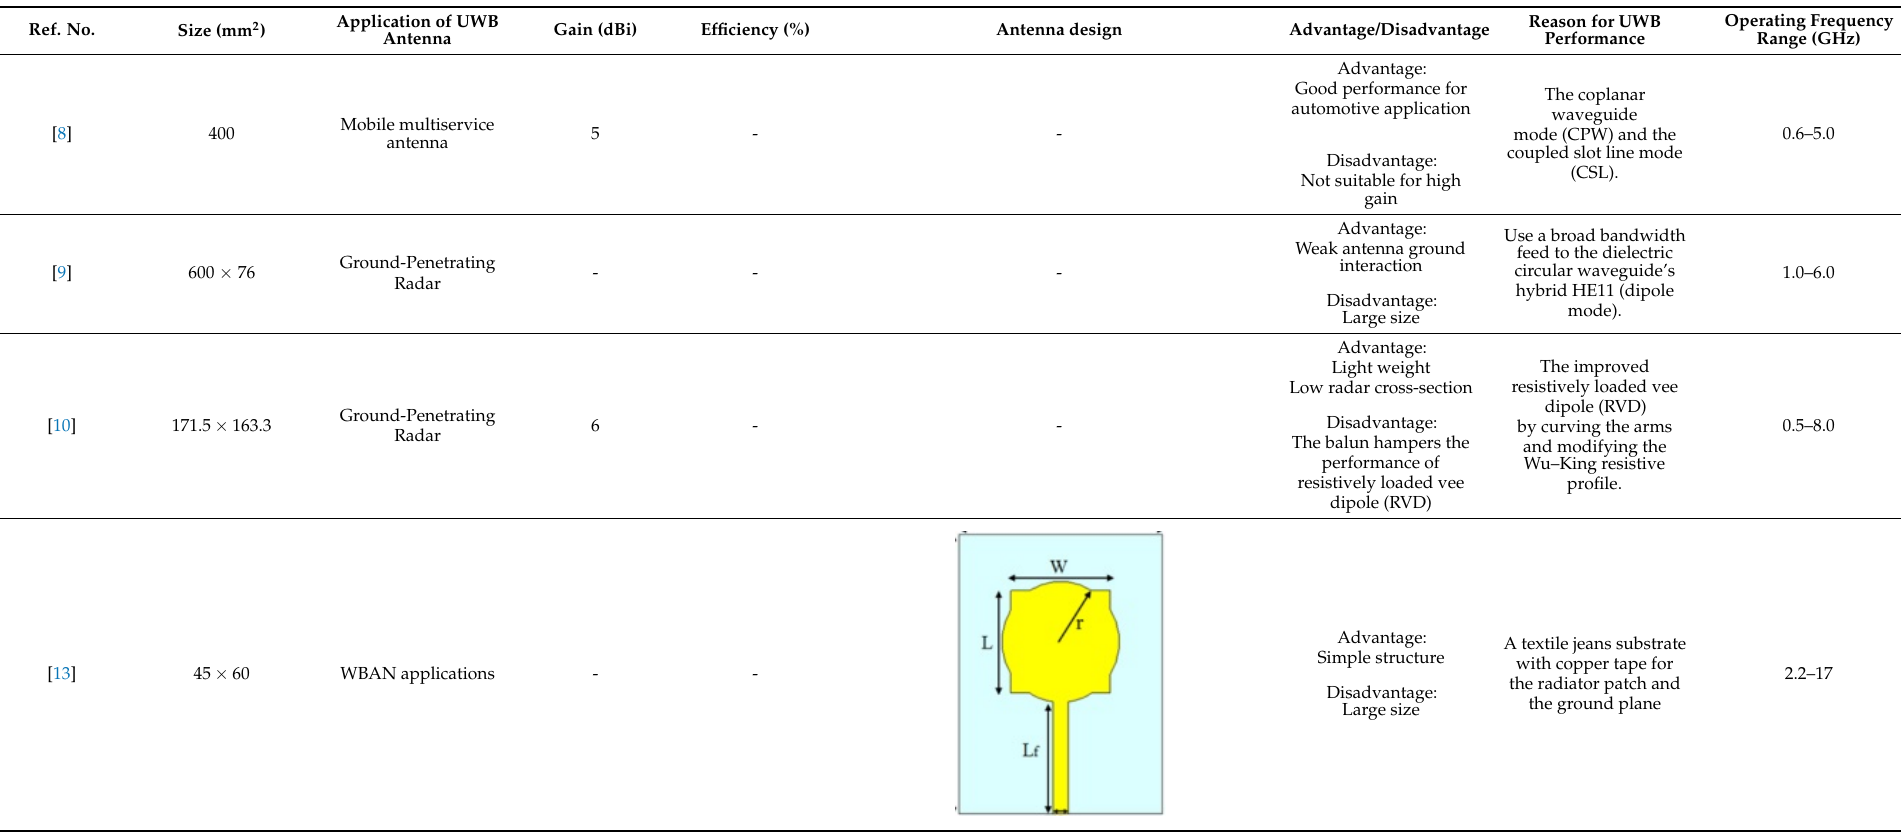
Table 1. The emergence of UWB technology and its